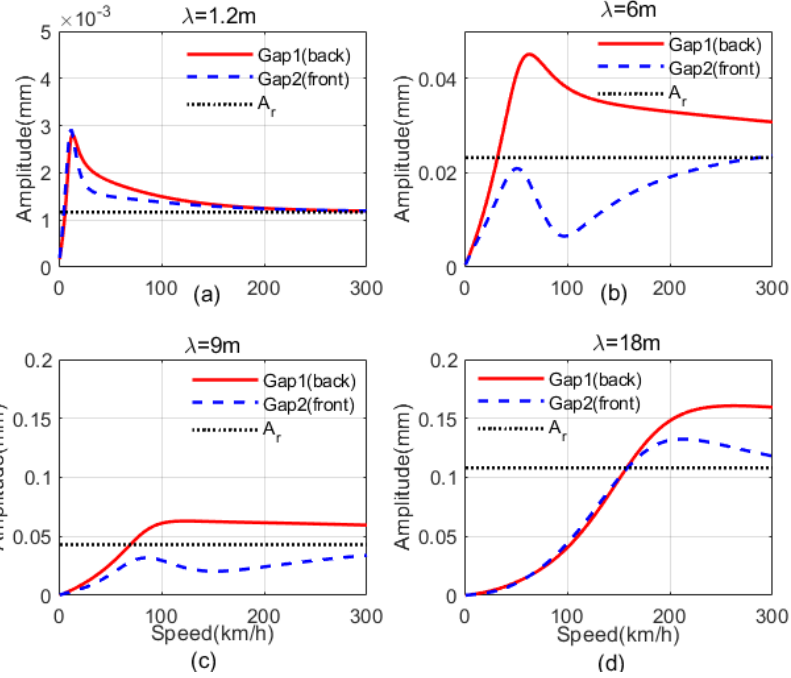
Figure 4. Amplitude spectrums of levitation gaps vs. vehicle speed. ( a ) at 1.2 m, ( b ) at 6 m, ( c ) at 9 m, ( d ) at 18